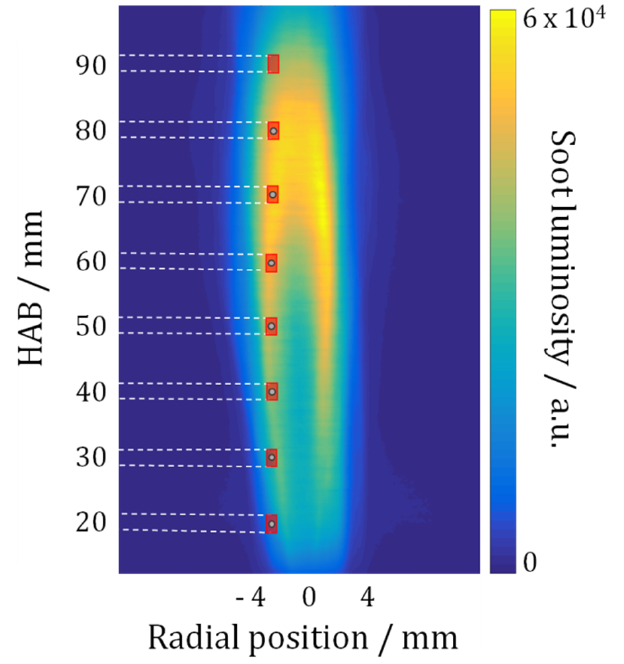
Figure 5. False color soot luminosity image of the laminar diffusion flame. The areas considered for further detailed LII and two-color pyrometry evaluation are highlighted with red rectangles while the grey dots represent the WALS measurement points.